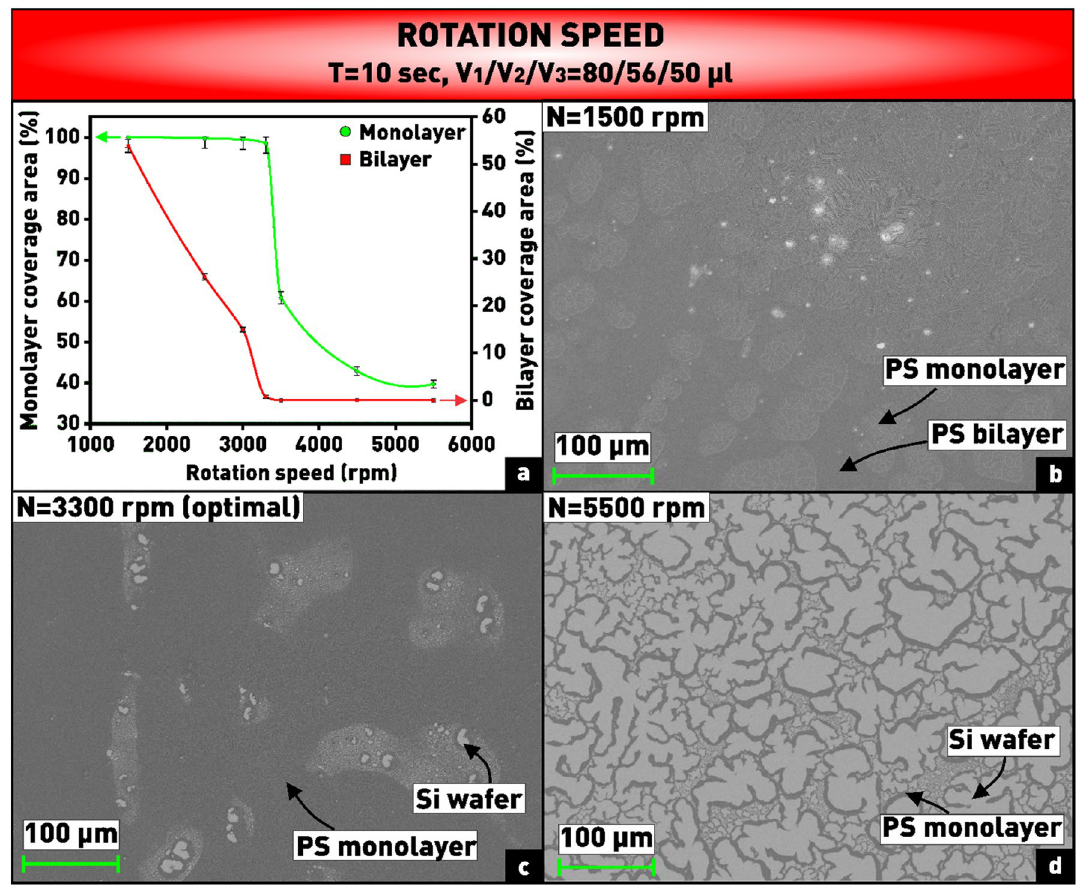
Figure 3. (a) Plot of dependence of substrate coverage area by monolayer and bilayer of PS nanospheres on spin speed; (b–d) microphotographs of nanosphere coatings obtained at varying spin